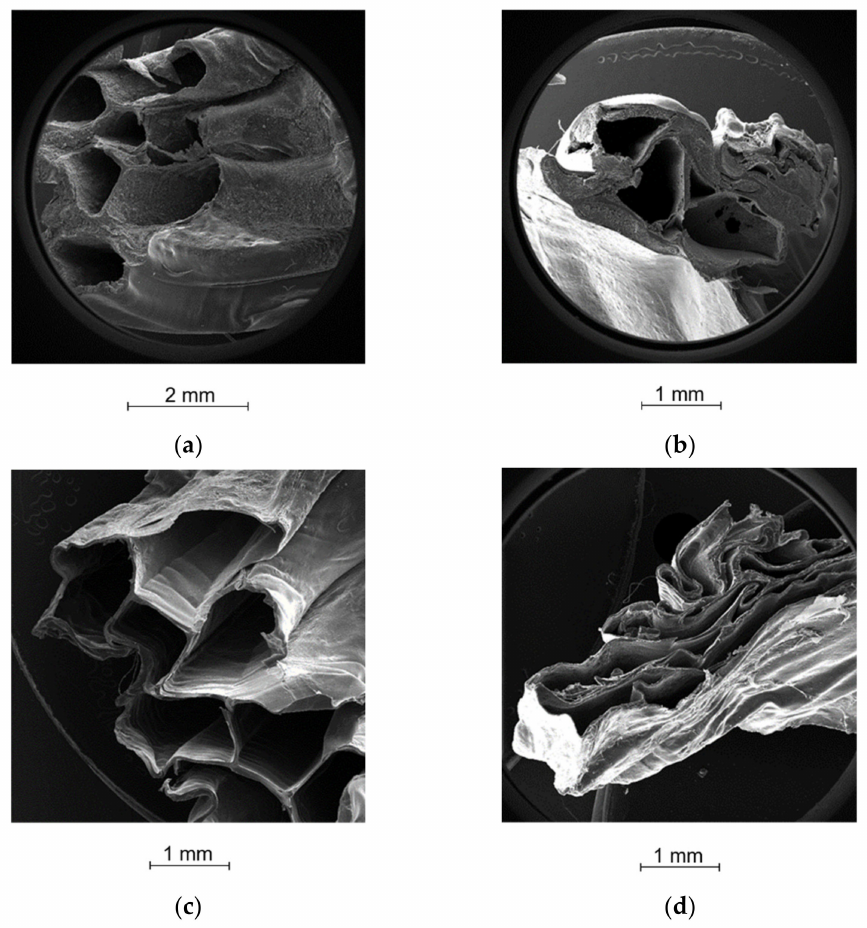
Figure 6. Cross-section SEM acquisition of ( a ) dried DDS0.10_5; ( b ) dried DDS0.05_5; ( c ) DDS0.10_5 after dissolution and re-drying; ( d ) and DDS0.05_5 after dissolution and